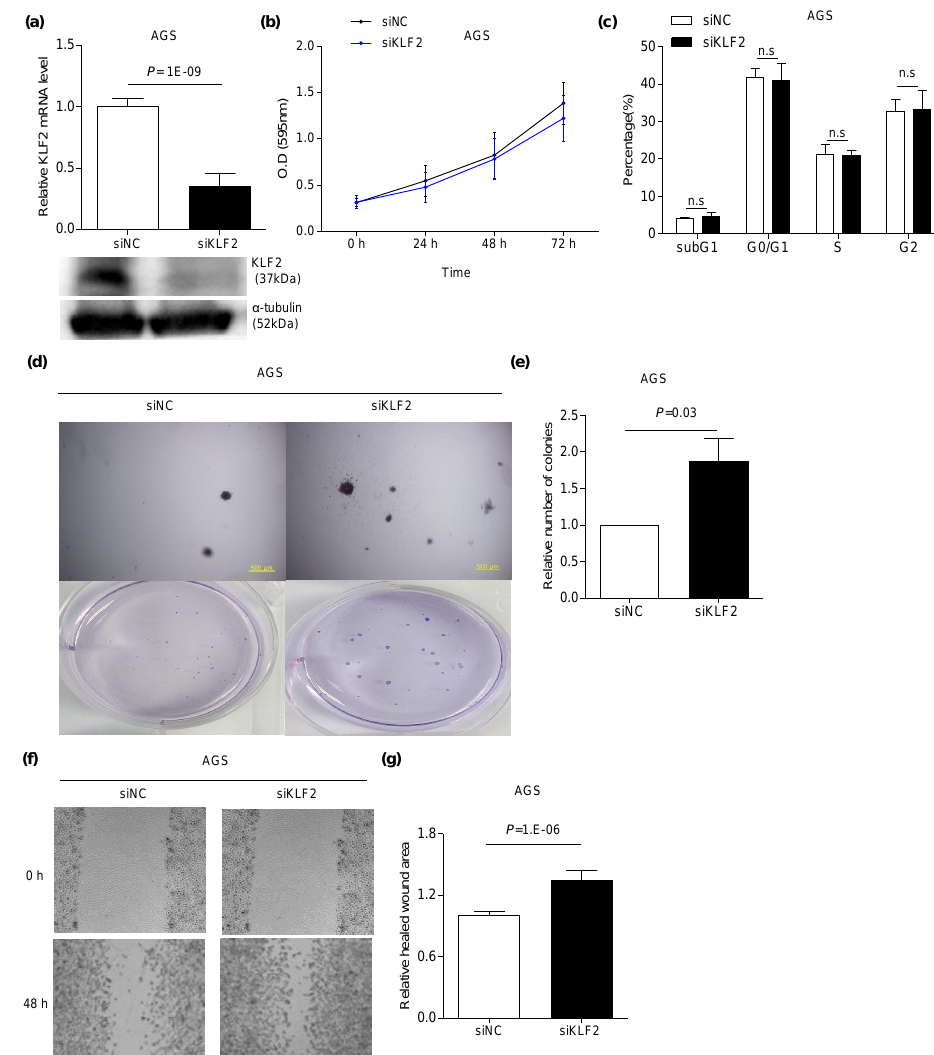
Figure 6. Promoted tumorigenesis of AGS cells through siKLF2. AGS cells were transfected with 30 nM siKLF2 ( a – g) . ( a ) KLF2 mRNA level was analyzed by qRT-PCR using a SYBR Green qPCR kit (Upper panel). Western blotting using anti-KLF2 (1:500) antibody showed expression of KLF2 . Anti- α -tubulin antibody was used for loading control (lower panel). All experiments were conducted three times independently. ( b ) Before and every 24 h after siKLF2 transfection, 20 µ L of MTT solution was added to each well to assess AGS cell proliferation in four independent experiments. ( c ) AGS cells were transfected with the negative control (siNC) or siKLF2. The proportion of the cells in each cell cycle phase was evaluated 48 h later by propidium iodide staining. All experiments were conducted four times independently. ( d ) To conduct soft agar colony formation assay, a transfected AGS cell was harvested after 24 h and seeded in agar. Cells placed in agar were observed after 4–6 weeks in three independent experiments. Upper panels were observed with microscope IX70 through a × 40 objective. Lower panels show the images taken with a camera. ( e ) Colonies were quantified using Image J software. Error bars indicate SD ( n = 3). ( f ) Wound-healing assay was performed on AGS cells transfected with 30 nM siKLF2 to assess KLF2 function in three independent experiments. ( g ) Healed wound area was measured by Image J software. Error bars indicate SD ( n = 3). Abbreviation: n.s, not